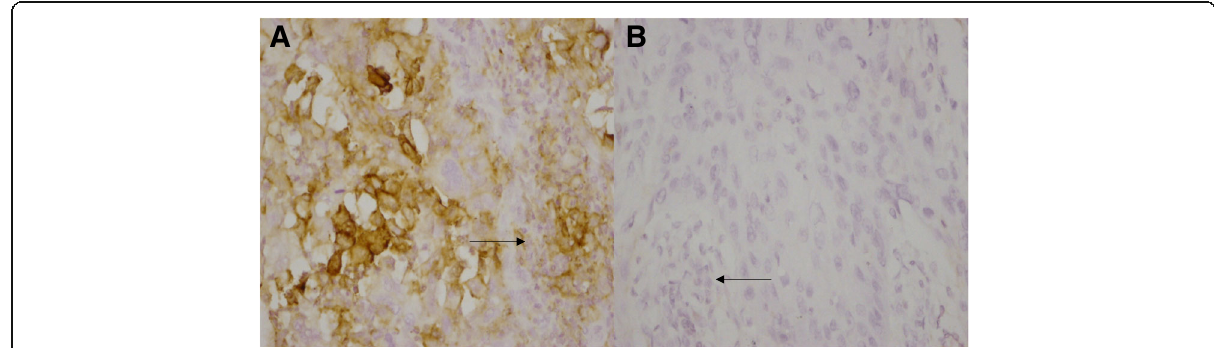
Fig. 2 PD-L1 expression in esophageal squamous cell carcinoma (ESCC) tumor cells and tumor-infiltrating immune cells. a PD-L1 positive expression in